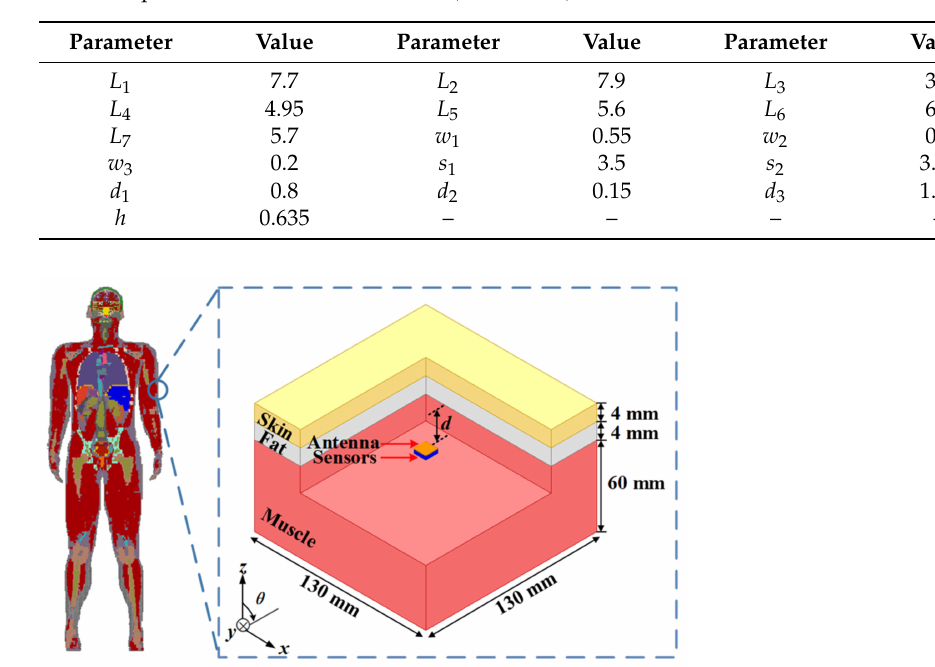
Figure 1. Geometry of the proposed implantable antenna. Table 1. Optimized Antenna Dimensions (UNIT: mm).